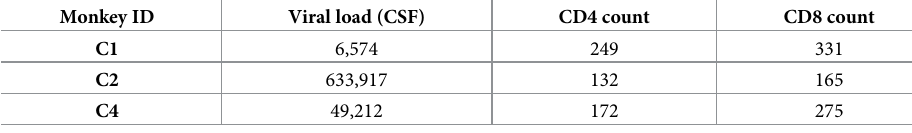
Table 1. CSF viral loads, CD4 and CD8 counts in SIV-infected